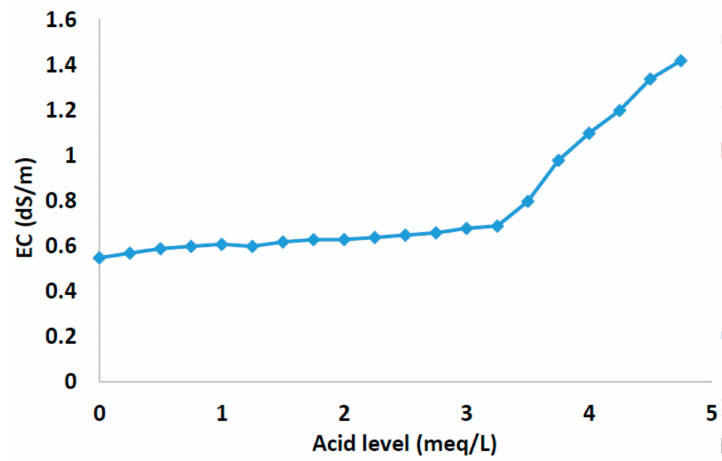
Figure 5. EC of water.